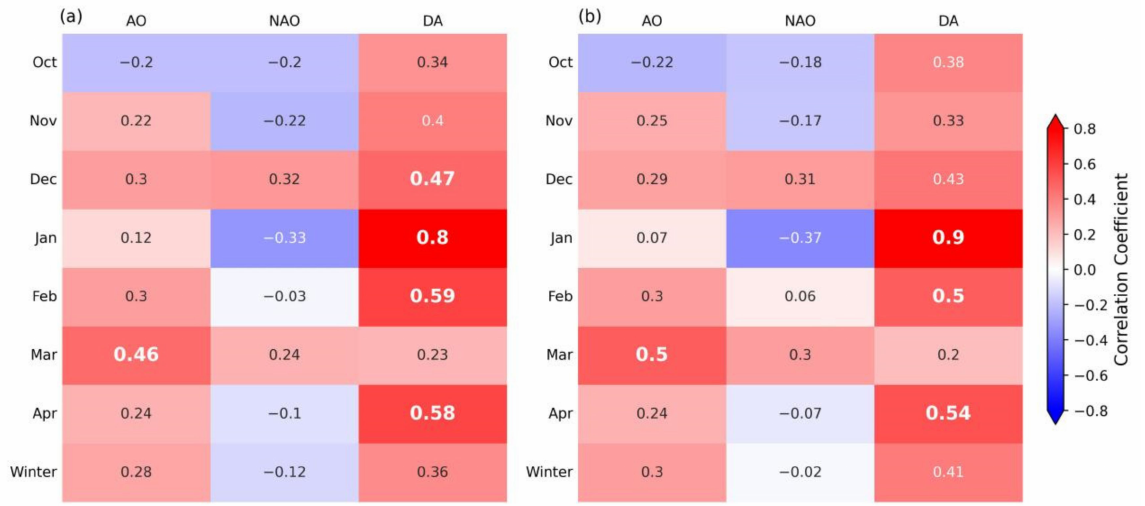
Figure 9. CCs between atmospheric indices and MYI areal flux through Fram Strait ( a ) and of the Arctic ( b